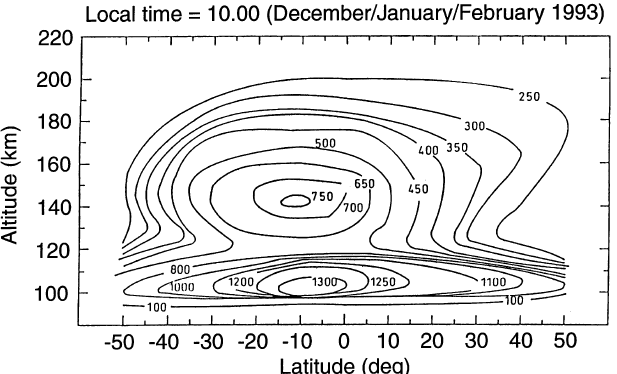
Fig. 6. The latitudinal variation of three monthly (December 1992/ January/February 1993) averaged volume emission rates as obtained from present model at 10 h local time